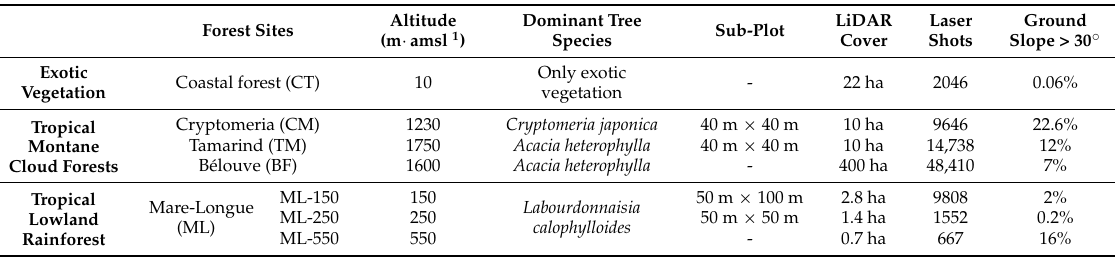
Table 1. Main characteristics of the study sites and associated available LiDAR